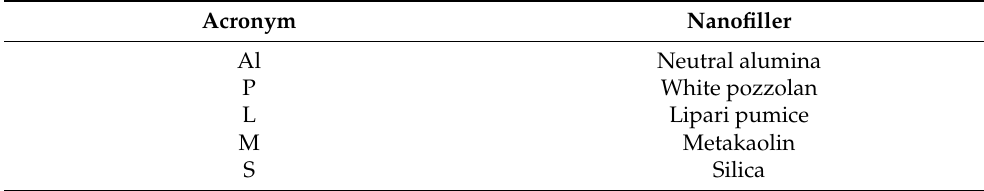
Table 2. Materials used for the adsorption tests of